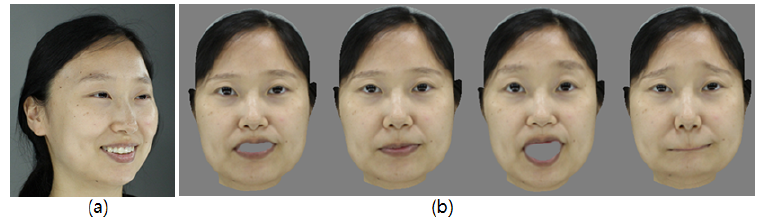
Figure 8. Synthesized facial expression results: ( a ) Input image. ( b ) Expression of synthesized faces.